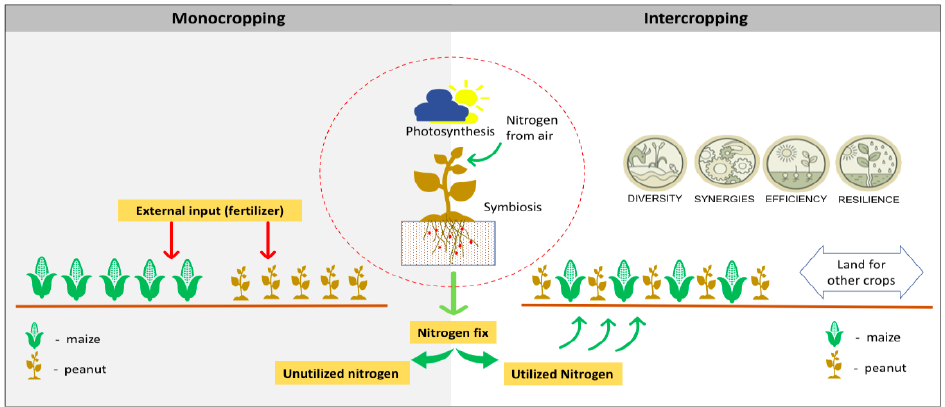
Figure 3. An example of how an intercropping system between cereal (maize) and legumes (pea- nut) can enhance soil health and diversity, relative to a monocropping system. can enhance soil health and diversity, relative to a monocropping